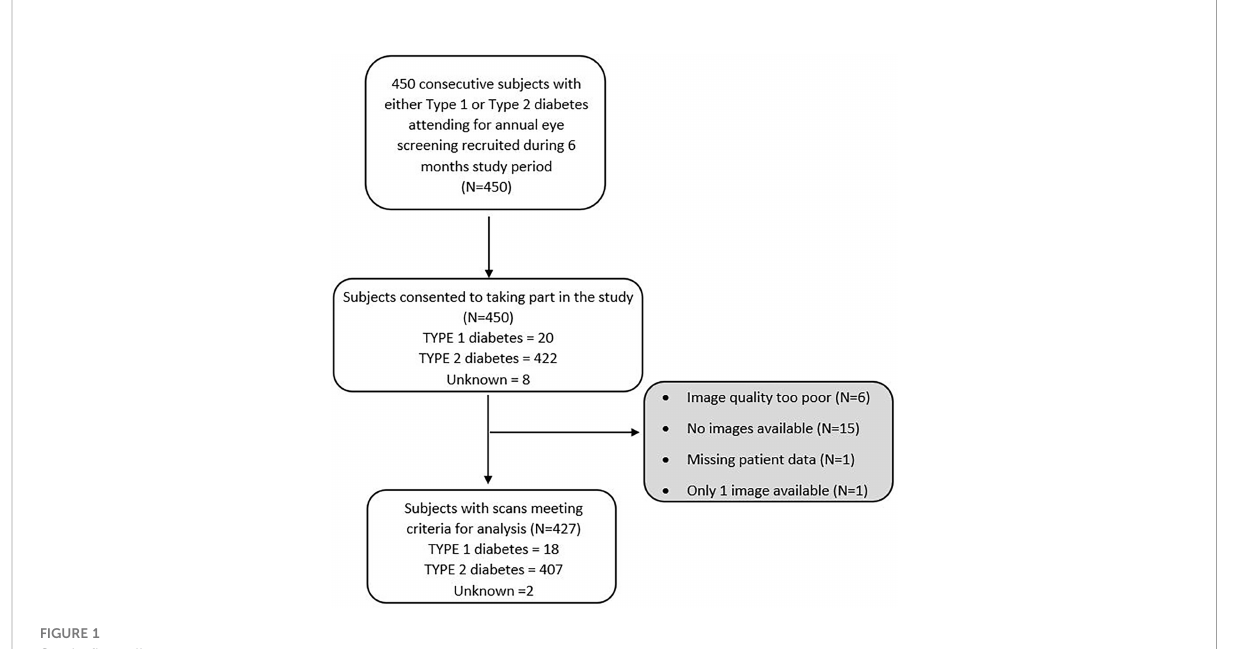
FIGURE 1 Study fl ow